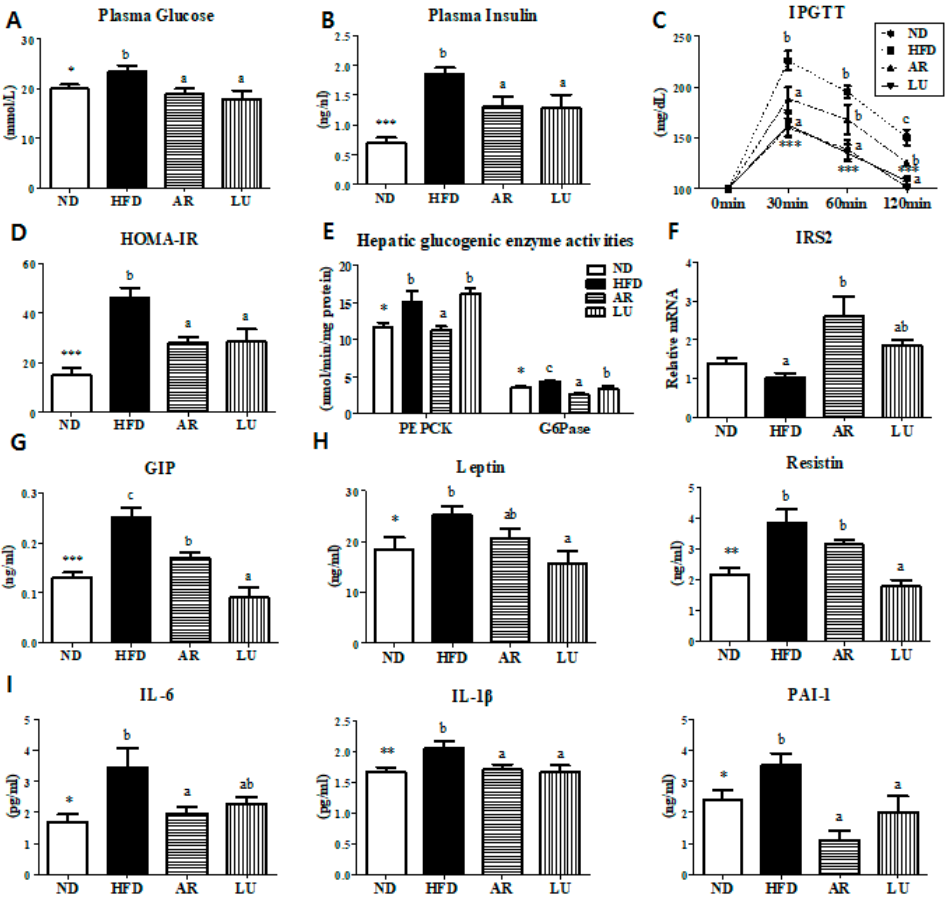
Figure 3. Effects of luteolin-enriched artichoke extract and luteolin on the plasma glucose ( A ) and insulin levels ( B ), IPGTT ( C ), HOMA-IR ( D ), hepatic glucogenic enzyme activity ( E ), hepatic IRS2